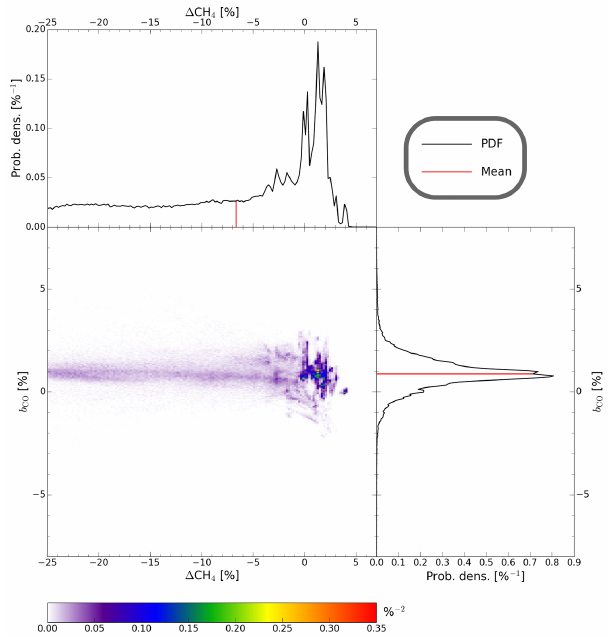
Figure 13. Middle panel: two-dimensional probability density func- tion of the methane filter ( (cid:49) CH 4 ) and the CO retrieval bias ( b CO ). Upper panel: one-dimensional probability density function of (cid:49) CH 4 (mean: − 6 . 7%, standard deviation: 8.4%). Right panel: one-dimensional probability density function of b CO (mean: 0.9%, standard deviation: